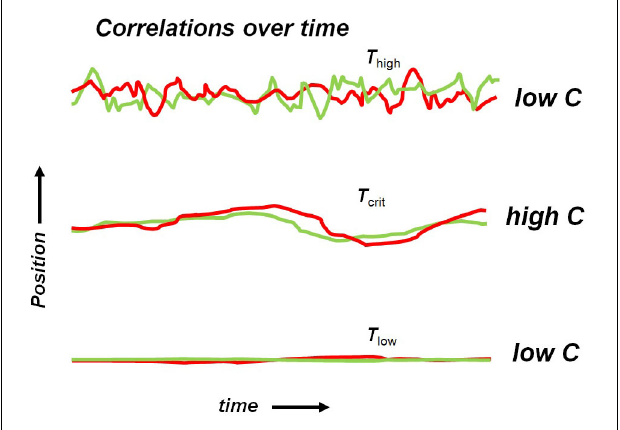
FIGURE 2 | Hypothetical positions of two spins as a function of time. (Top) At high temperature, the spin orientations fluctuate greatly, but independently of one another, producing a low dynamic correlation value. (Middle) At the critical temperature, the spin orientations fluctuate somewhat and the fluctuations are coordinated, producing a high dynamic correlation value. (Bottom) At low temperature, the spin orientations do not fluctuate very much, yielding a low dynamic correlation value.